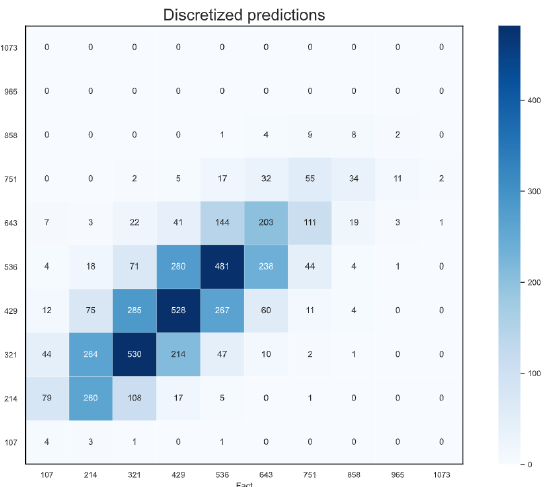
Figure 16. Discretised prediction output from the hybrid CNN. Predictions are binned into ten bins. The axes’ labels mark the upper bound of each bin.